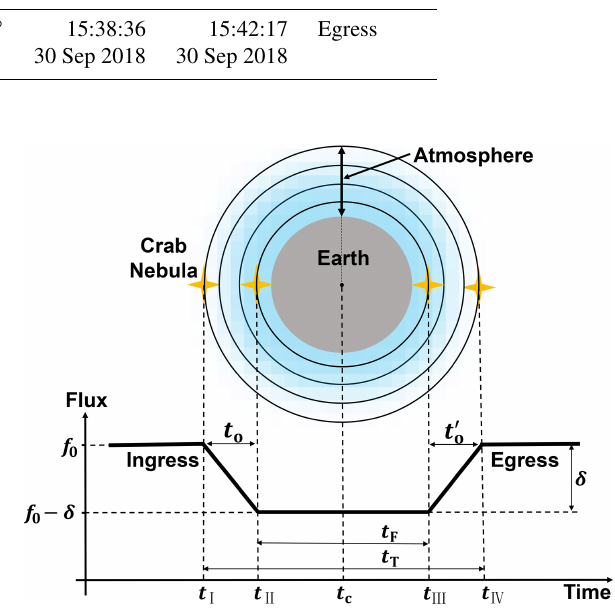
Figure 3. The comparison of the X-ray energy spectra during the occultation process. These spectra cover an energy range of 1– 10keV (0.1240–1.2398nm). The unattenuated X-ray energy spec- trum is shown in blue. The red, orange, and purple data points are the attenuated X-ray energy spectra with the decreasing tangent point, respectively. The energy spectrum in green is the fully at- tenuated X-ray spectrum.